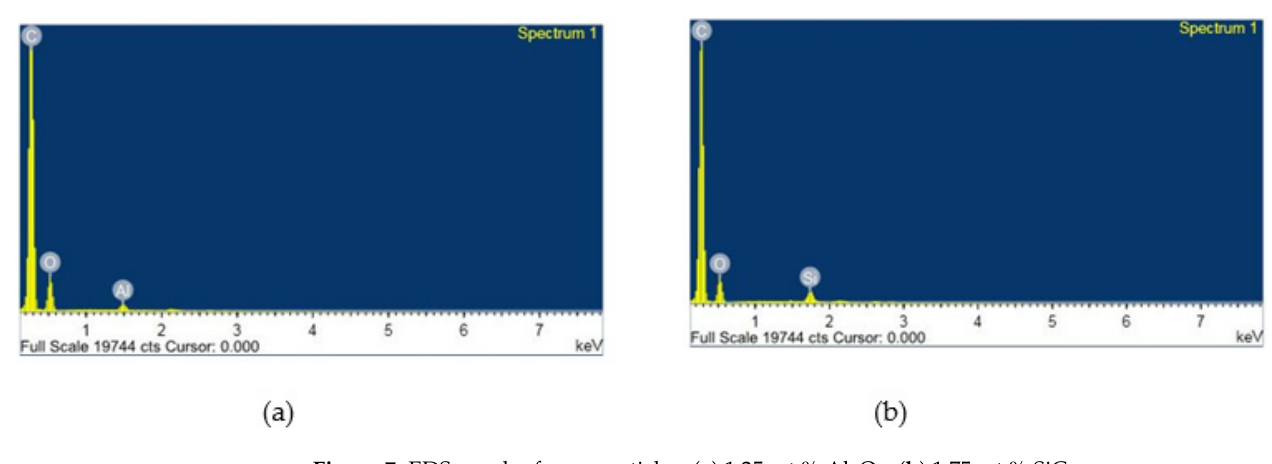
Figure 6. Agglomeration of nanoparticles: ( a ) 2 wt.% Al 2 O 3 , ( b ) 2 wt.% SiC.